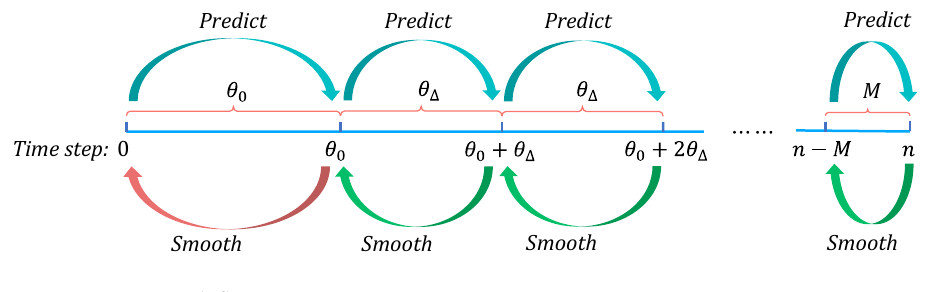
Figure 4. ERTSS work flow.